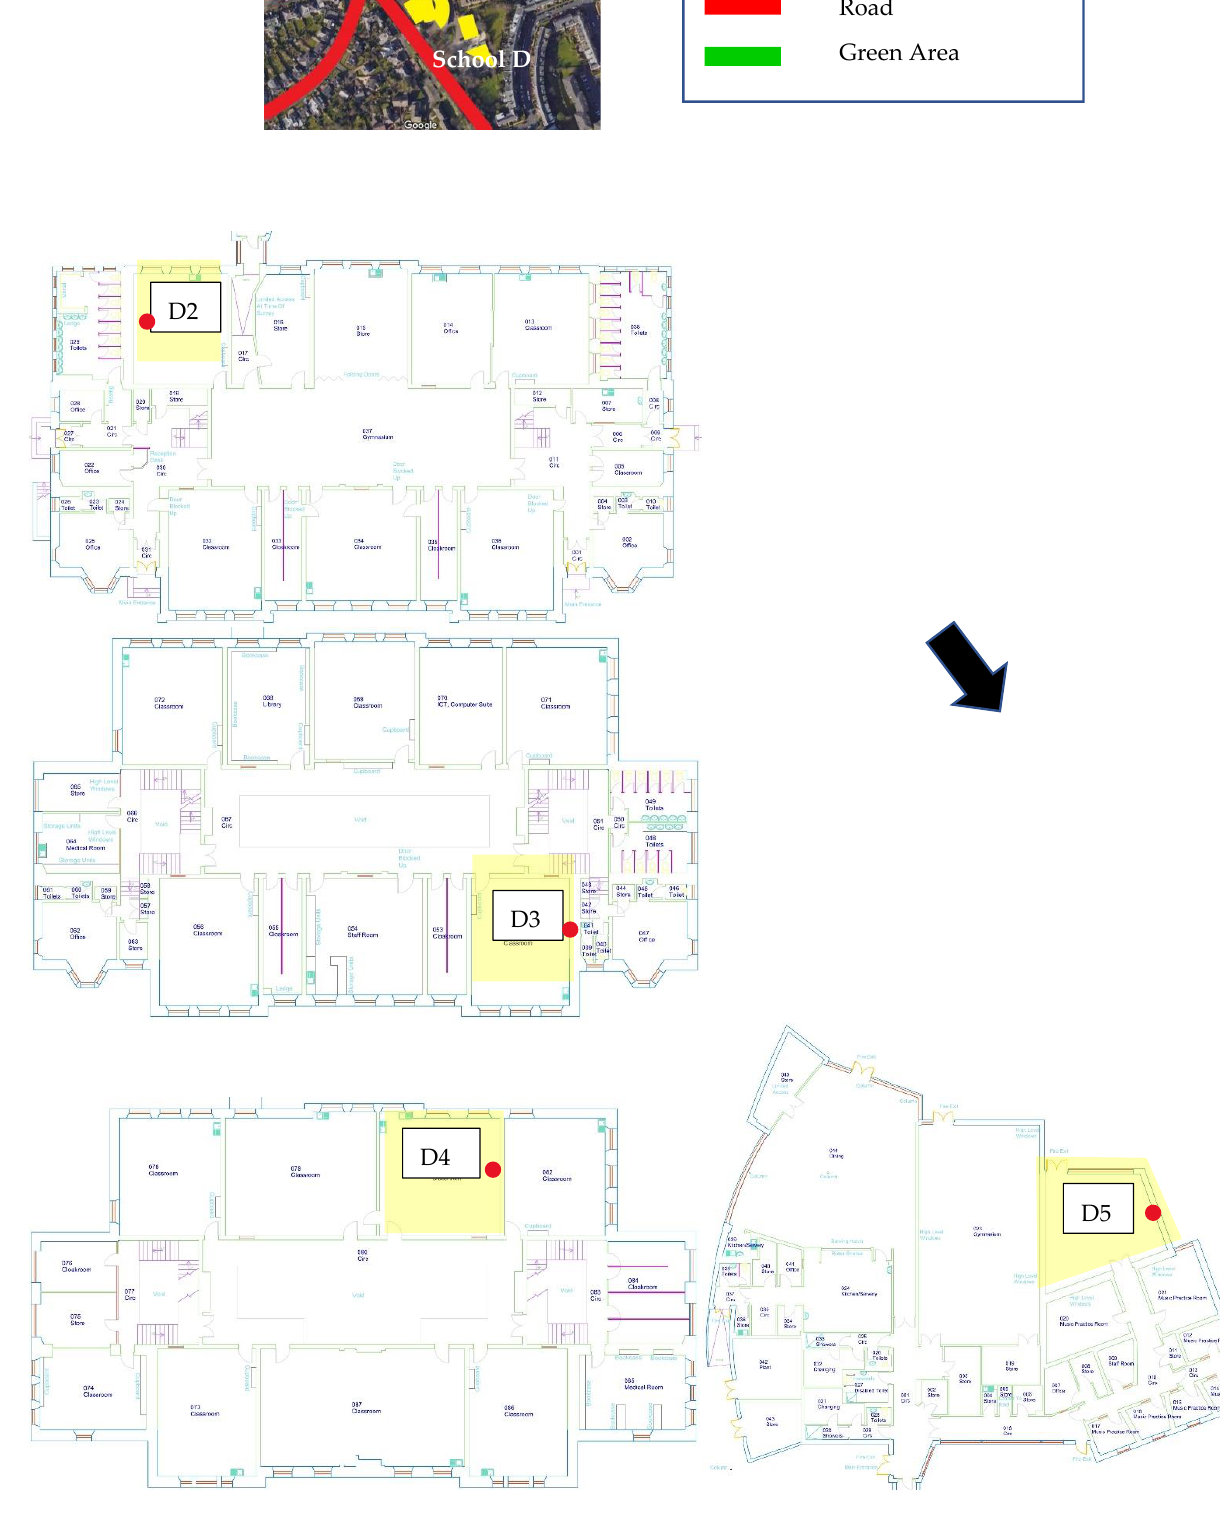
Figure 12. School